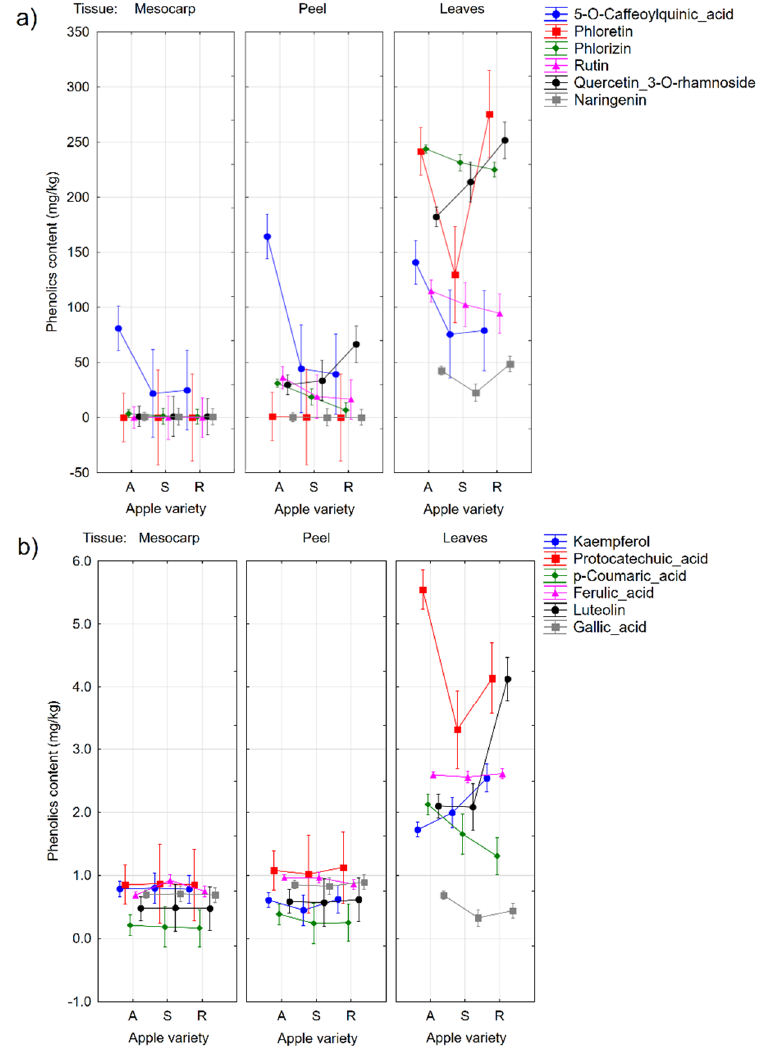
Figure 2. The plot of the MANOVA factor effects influencing the phenolic compound content in the different plant parts (tissues) across the different sort types. The phenolic content was plotted on the y − axis; the plant part and the cultivar group (A—autochthonous, S—standard, R—resistant) are plotted on the x − axis. ( a ) phenolic macro components, and ( b ) phenolic micro components. Vertical bars denote 0.95 confidence intervals.